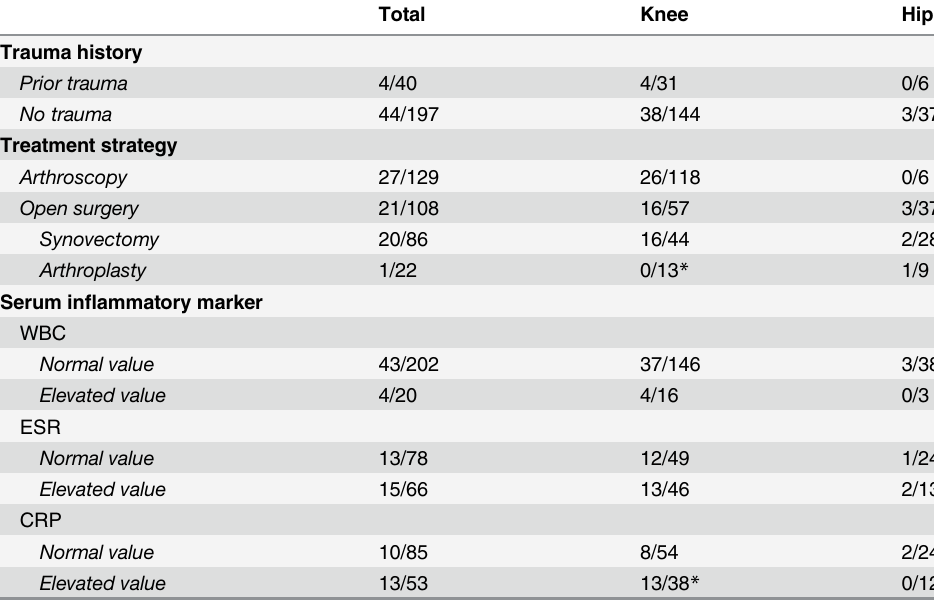
Table 4. Clinical and laboratory presentation of recurring PVNS